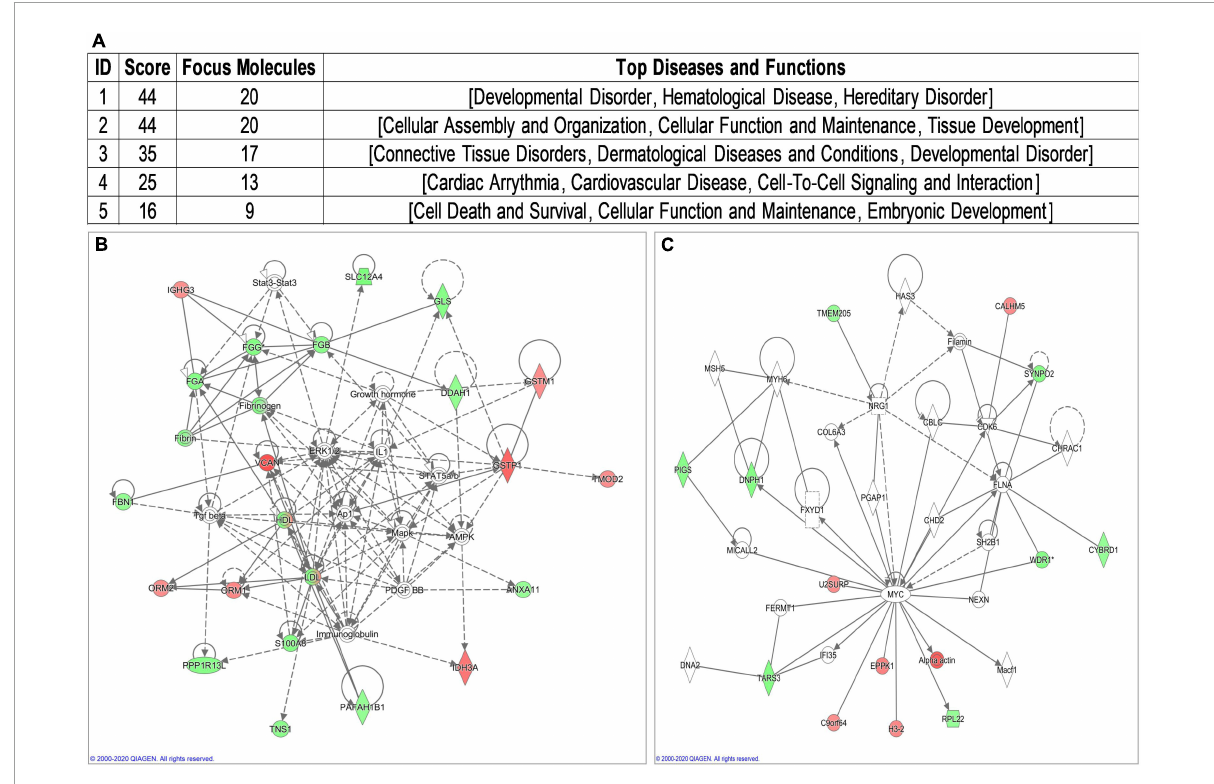
FIGURE2 Visual representation of the principal network generated by ingenuity pathway analysis (IPA). (A) Principal network generated by IPA. (B) Developmental Disorder associated network. (C) Cardiovascular Disease associated